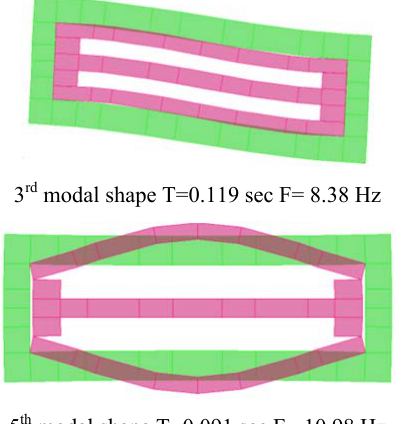
Figure 13. Modal Shapes